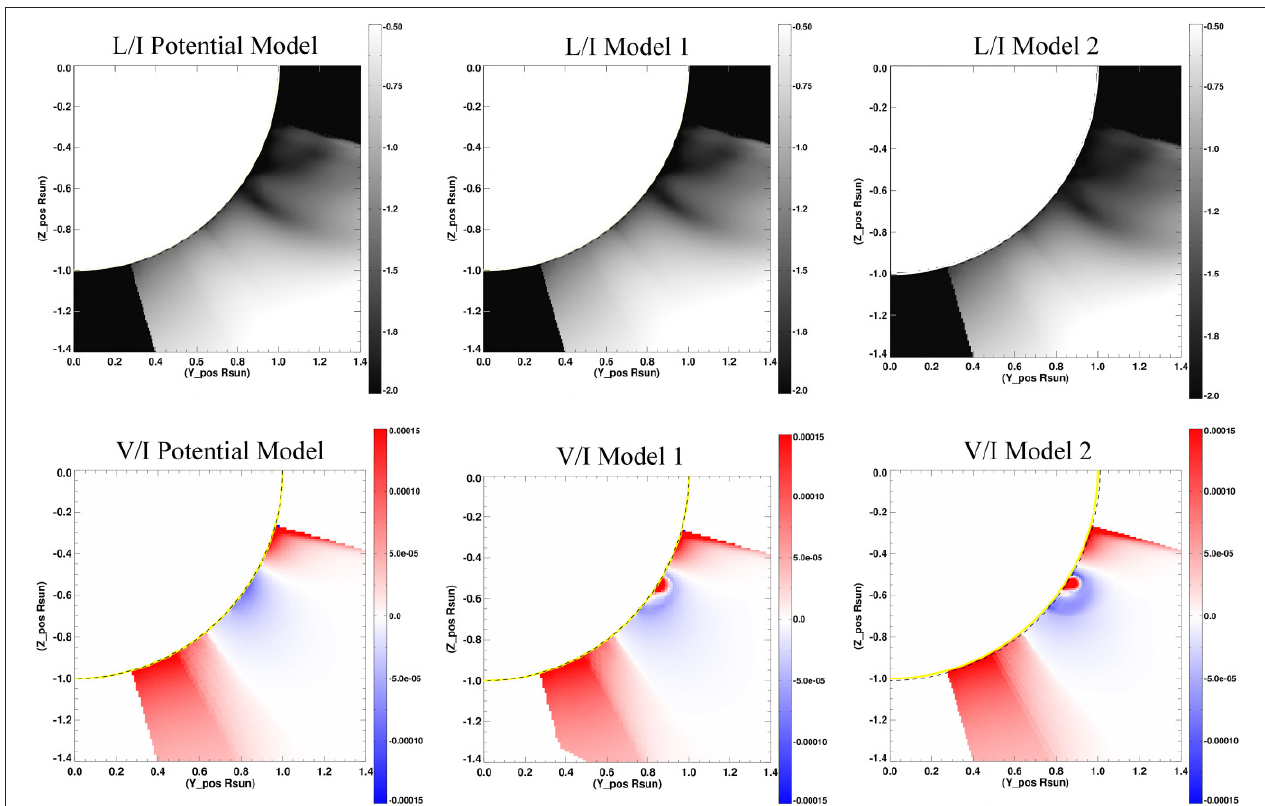
FIGURE 13 | Top row: L / I (log scale) of the potential arcade model (left) , weakly twisted flux rope (middle) , and highly twisted flux rope (right) . Bottom row : relative circular polarization ( V / I ) for the potential arcade model (left) , weakly twisted flux rope (middle) , and highly twisted flux rope (right)